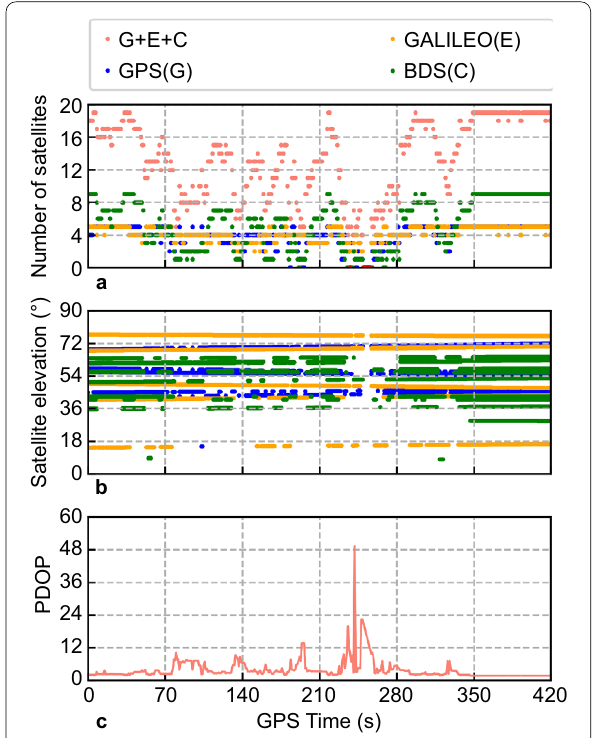
Fig. 6 Number of available GNSS satellites ( a ), continuity and elevation of satellites ( b ), PDOP of multi-GNSS PPP ( c ) in GNSS partly-blocked experiment